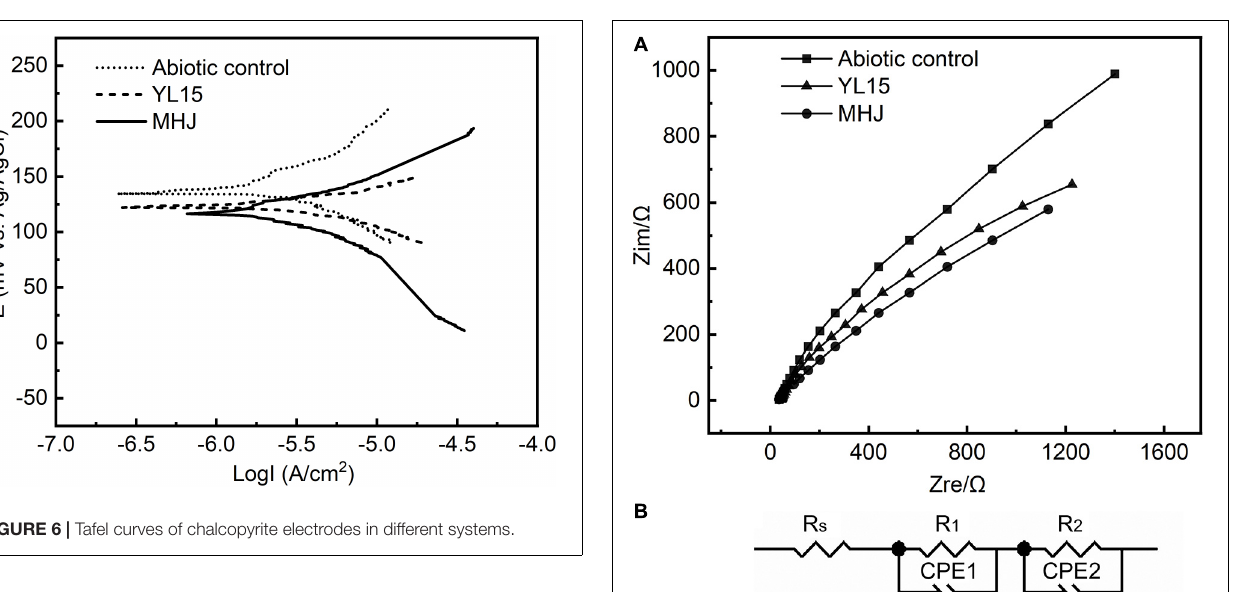
TABLE 1 | Tafel parameters of chalcopyrite electrodes in different systems.